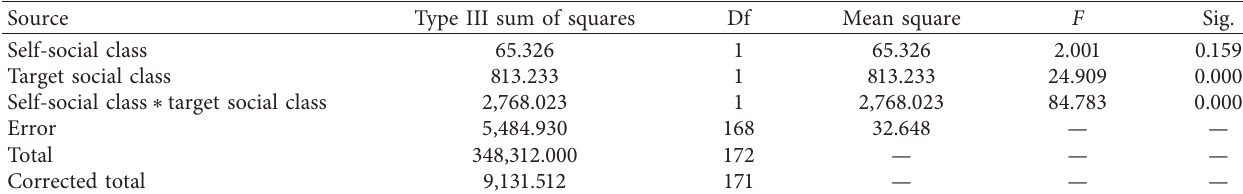
Table 2: The ANOVA results of two-factor between-subjects experiment design.